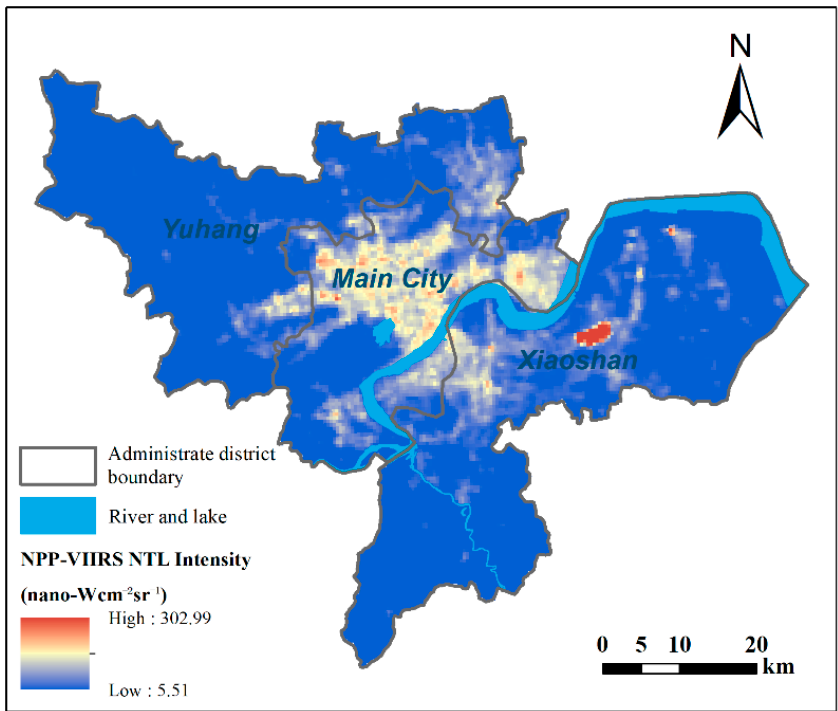
Figure 4. NPP-VIIRS nighttime light intensity map of Hangzhou in May 2018. (NPP-VIIRS: Suomi-NPP satellite, visible infrared imaging radiometer).